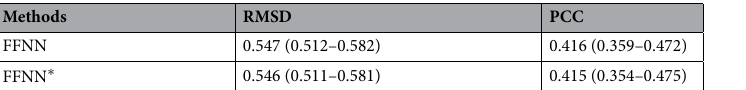
Table 4. Assessing the impact of the missing values imputation on ALSFRS slope performance with the top 5 most important features. RMSD and PCC are presented for the two FFNN methods: FFNN was trained on ∗ imputed n = 2338 patients, while FFNN on n = 1748 non-imputed ones. Both models were then tested on n = 583 non-imputed